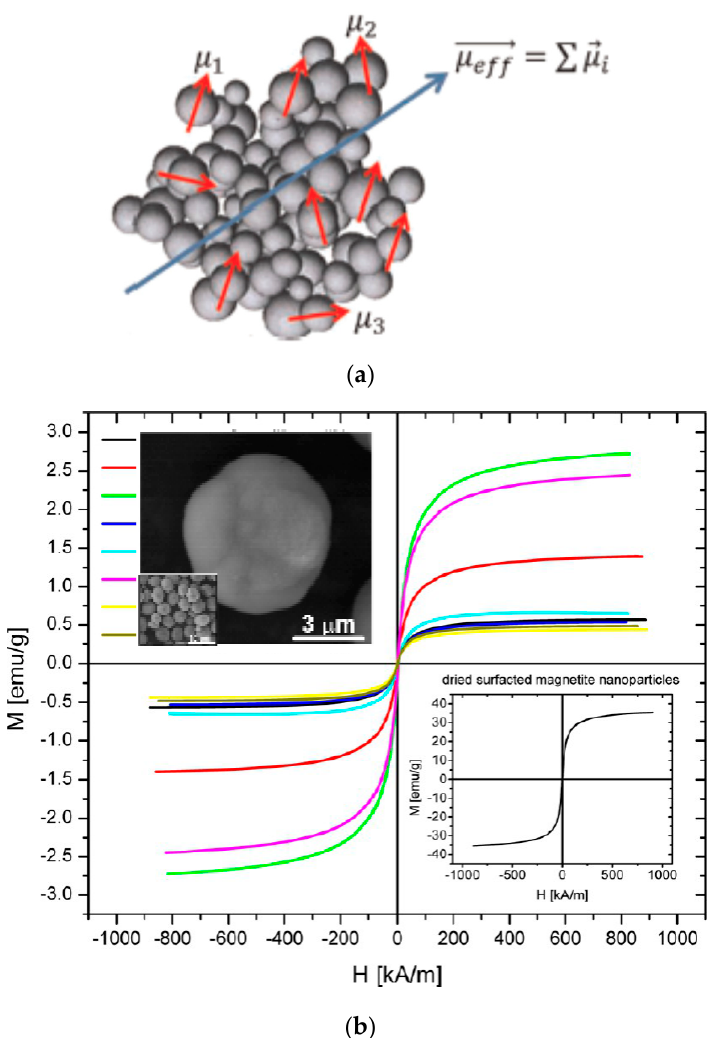
Figure 24. ( a ) Magnetic multi-core particle (reprinted from [77], Copyright 2015, with permission from Elsevier), and ( b ) Magnetization curves of the dried composite microparticles. Inset shows the magnetization of the dried surface coated magnetite nanoparticles. (Reprinted with permission from [167]. Copyright 2013 American Chemical Society.).